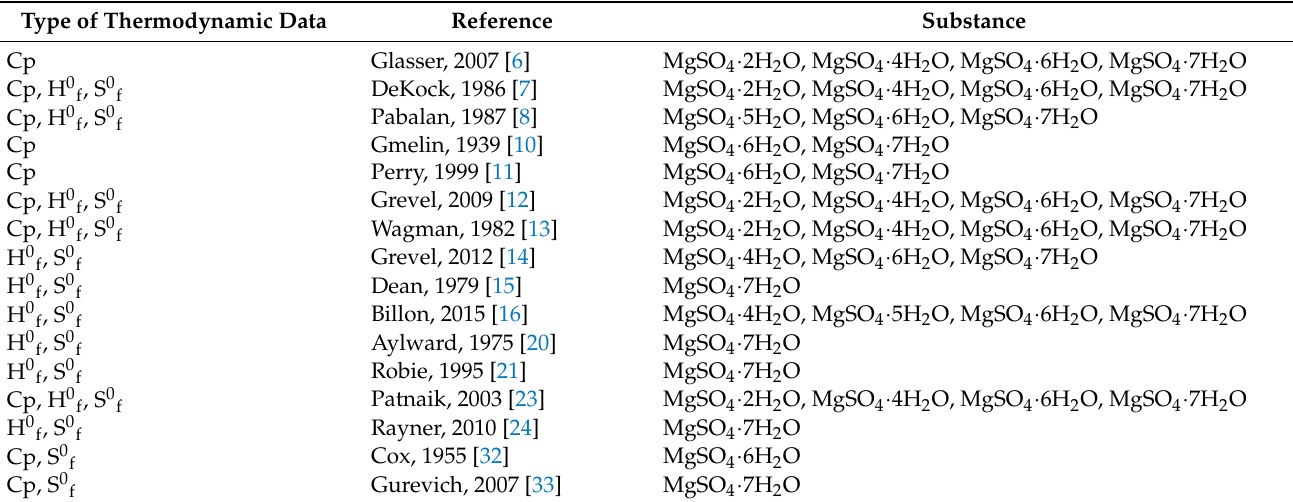
Table 4. Gathered thermodynamic data for MgSO 4 · 2H 2 O, MgSO 4 · 4H 2 O, MgSO 4 · 5H 2 O, MgSO 4 · 6H 2 O, and MgSO 4 · 7H 2 O. Type of Thermodynamic Data